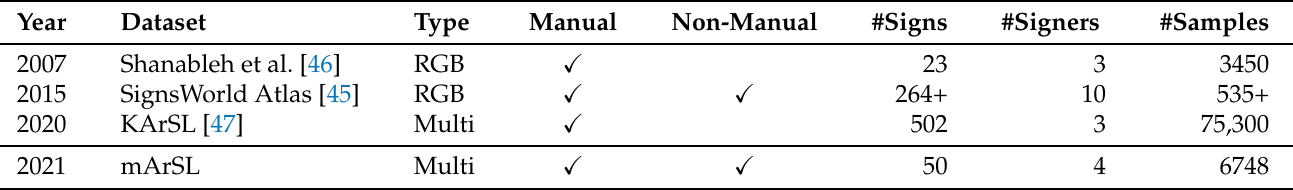
Table 2. Comparisons of our mArSL database with existing ArSL